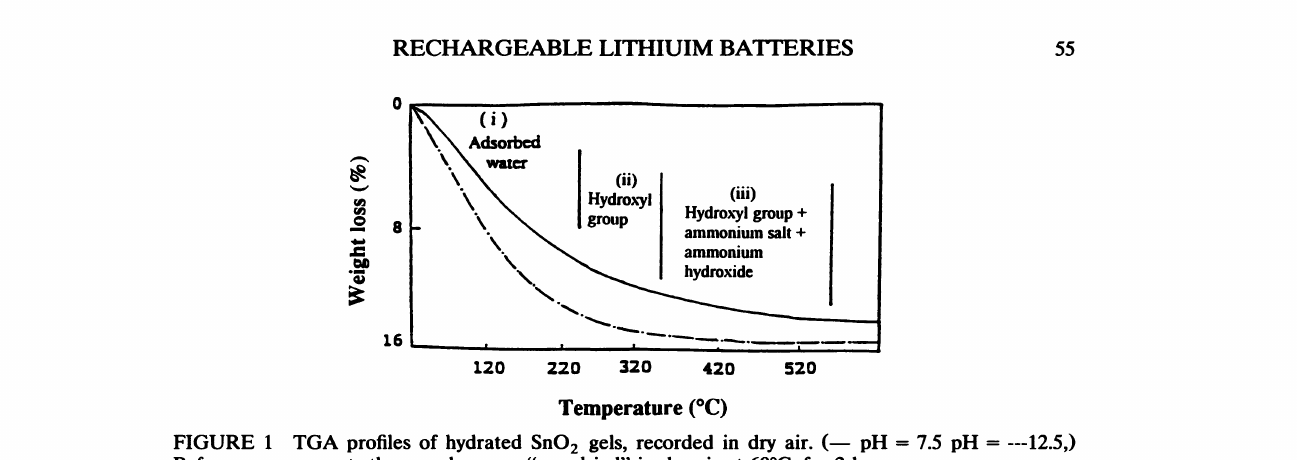
FIGURE TGA profiles of hydrated SnO_ gels, recorded in dry air. (-- pH 7.5 pH 12.5,) Before measurements the samples were "pre-dried" in dry air at 60C, for 2